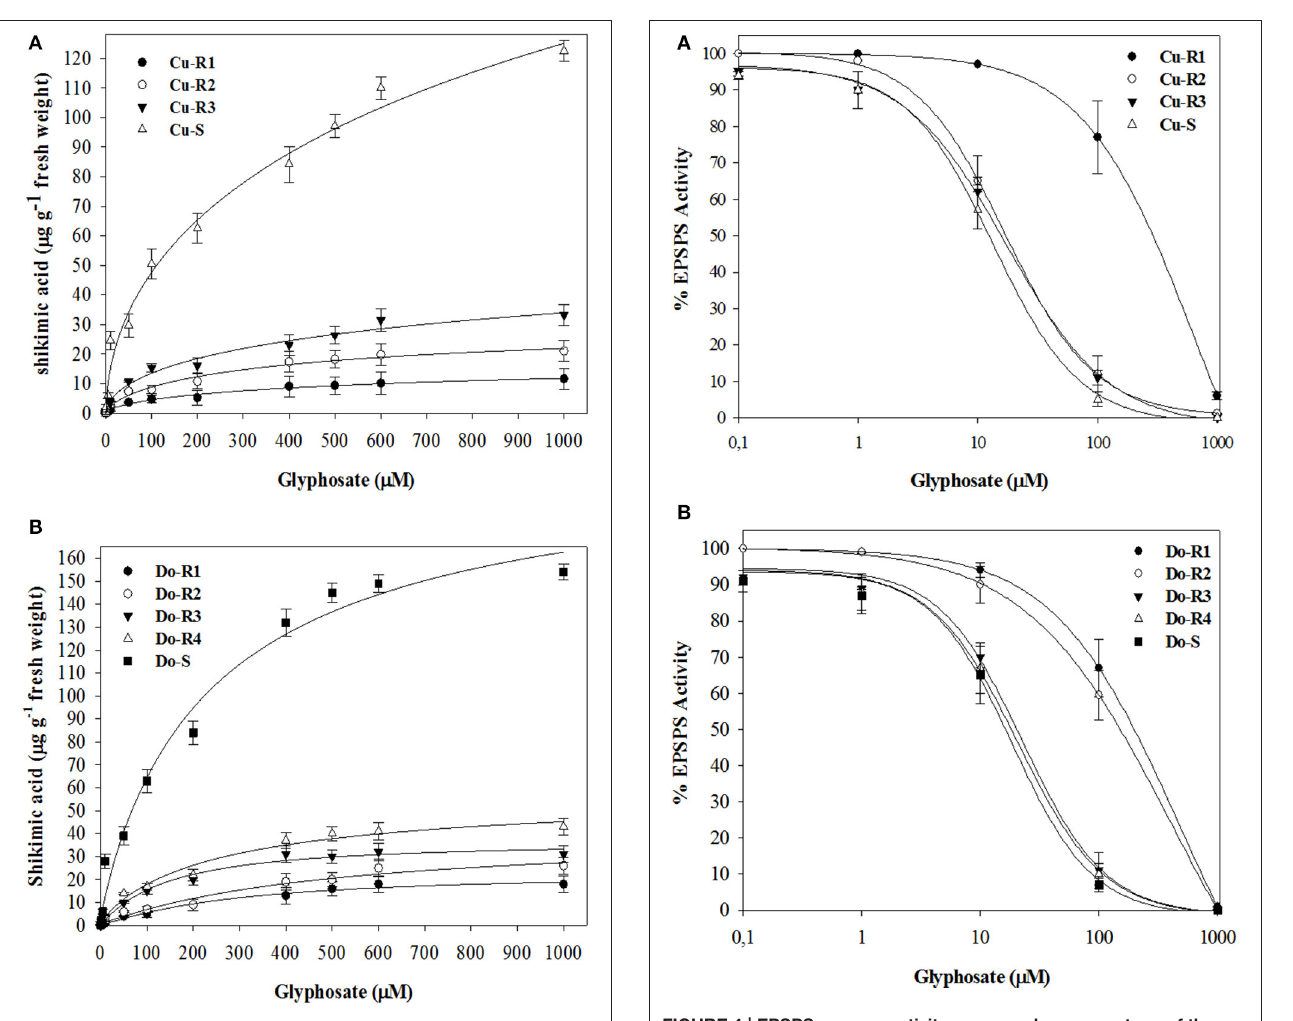
FIGURE 3 | Shikimic acid accumulation in leaf segments of plants from Cuba (A) and Dominican Republic (B) accessions of P. hysterophorus . Symbols denoted mean ( n = 3) ± standard errors of the mean.